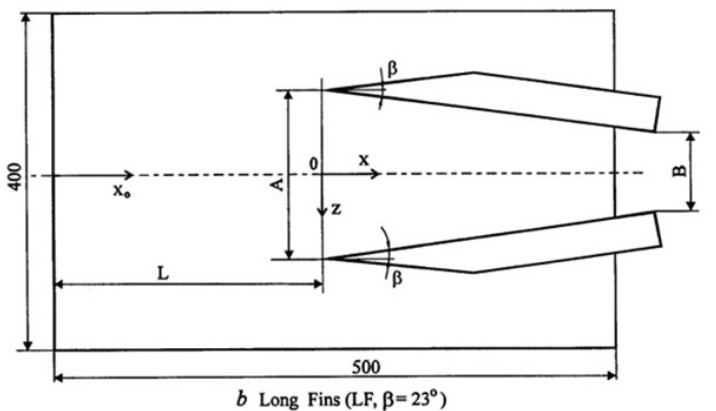
Figure 7. Simulated crossing shock